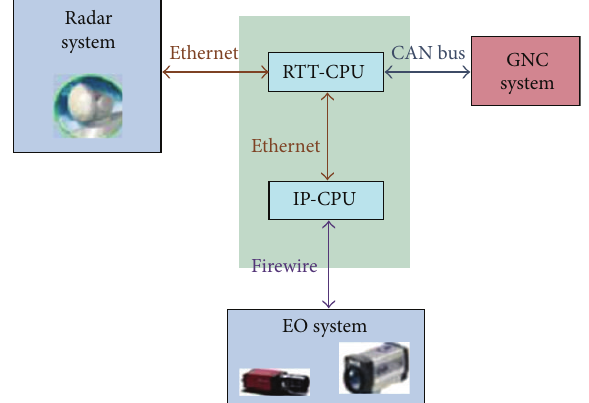
Figure 1: Flight system hardware architecture.